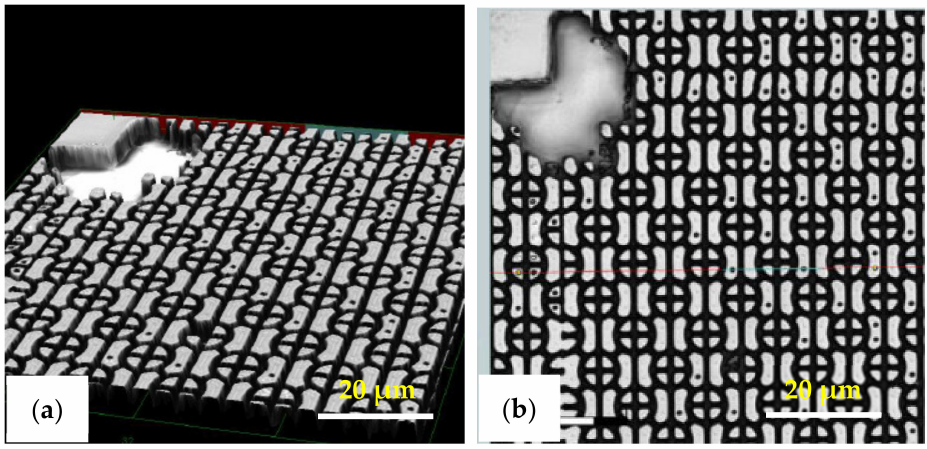
Figure 14. Laser confocal microscopy images of the C-RESS micro-structure (pattern design: size: 1.5 µ m, space: 0.5 µ m, height: 2.5 µ m) on the ( a ) imprint on PC foil with resin A (C-RESS-A), and ( b ) imprint on PC foil with resin B